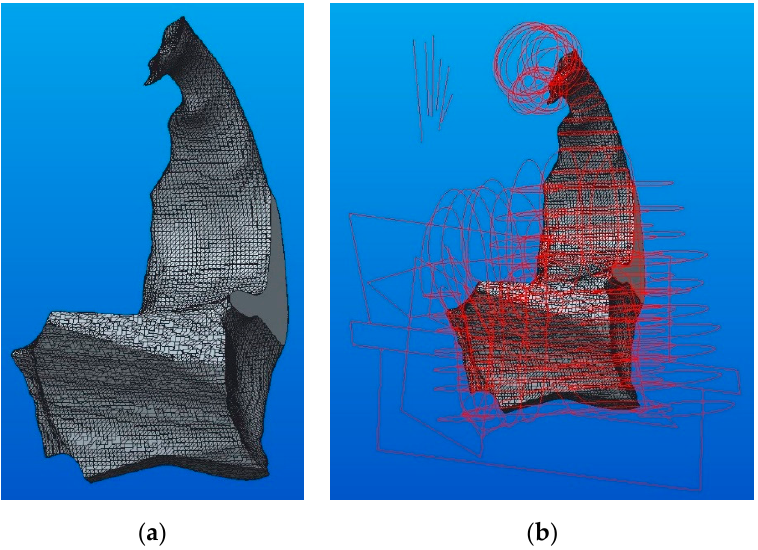
Figure 13. The B component tracing: ( a ) Shrinkwrap model; ( b ) sketches necessary for modeling.